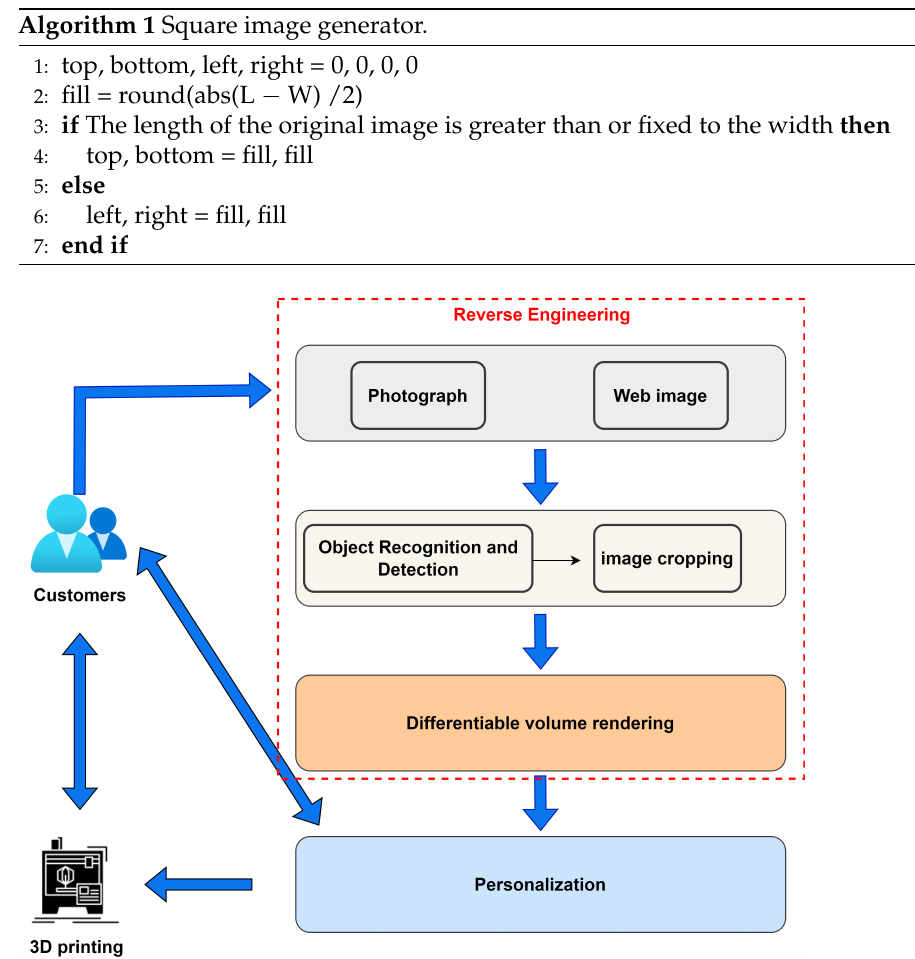
Figure 1. A P2P cloud manufacturing method based on personalized business